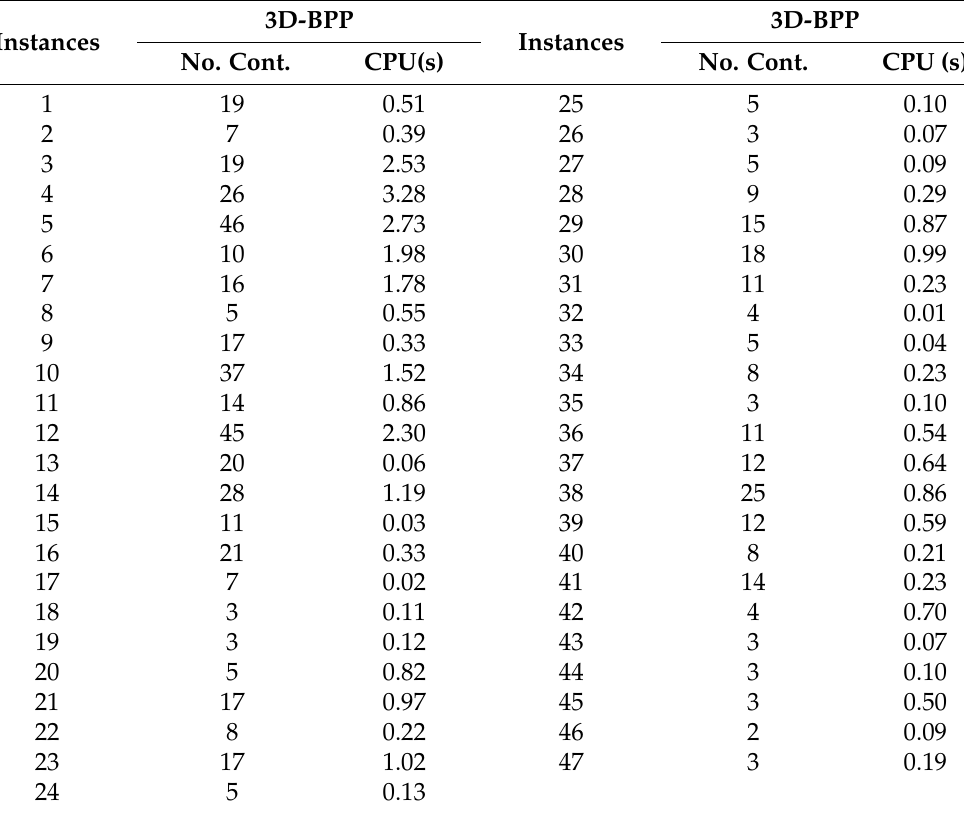
Table 3. Experimental results for the adapted benchmark instances for the 3D-BPP (pallets loading). 3D-BPP Instances